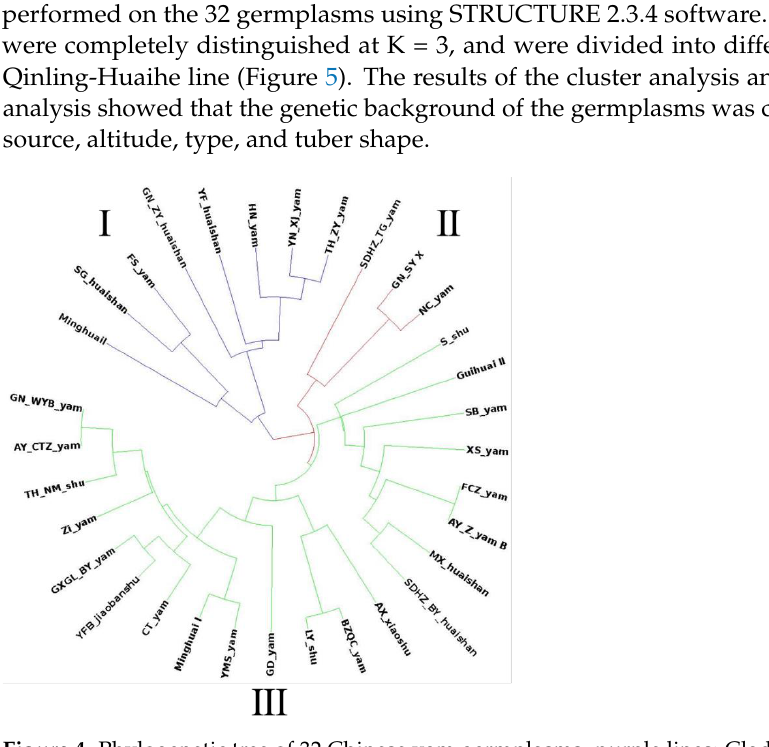
Figure 5. Population structure analysis of 32 Chinese yam accessions. ( A ) Population structure based on K = 3. When K = 3, red: Group 1; green: Group 2; blue: Group 3. ( B ) Delta K based on the rate of change of L (K) between successive K values. ( C ) Evanno table output. 4. Discussion Yam is a highly productive and efficient cash crop for food and medicine. China has a wide variety of yam species and a large cultivation area, but there are problems such as confusing names, degraded varieties, poor quality, and low yields [31]. Meanwhile,